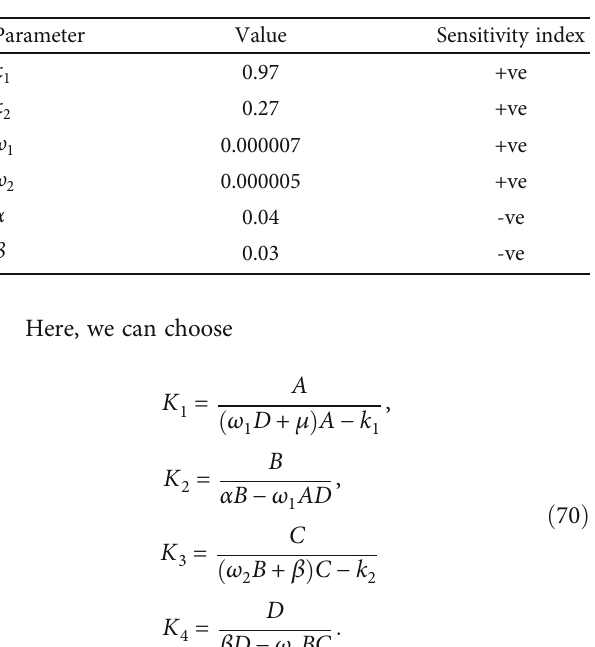
Table 2: The parameter values and sensitivity index of